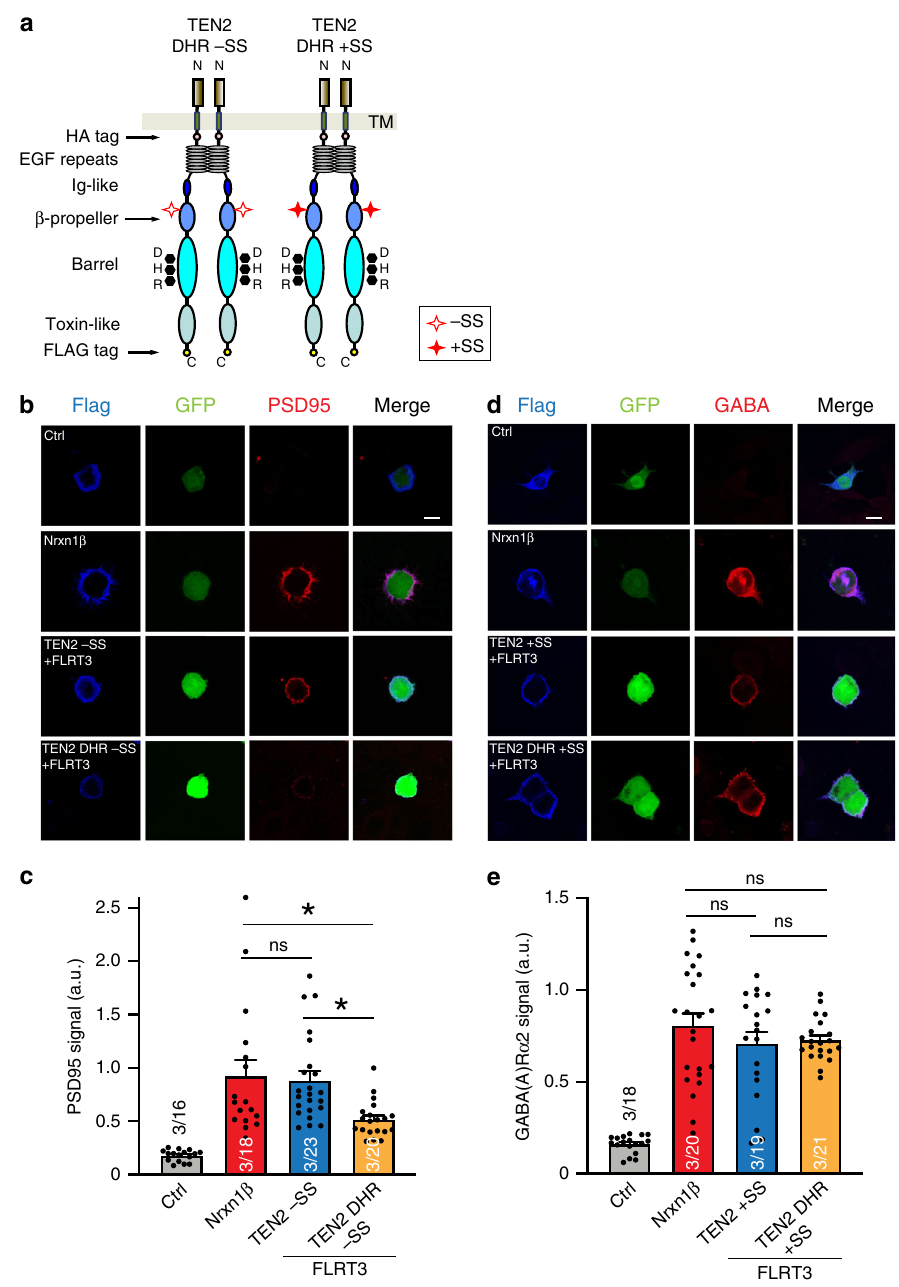
Fig. 7 Binding site mutations on TEN2 selectively abolish excitatory but not inhibitory synapse formation. a Diagram for TEN2 DHR − SS and TEN2 DHR + SS constructs that were used in the below experiments. The seven amino acid splice site on the TEN2 β -propeller is indicated by empty or fi lled red stars; DHR mutation is indicated by black dots. b , c Arti fi cial synapse formation assay showing that LPHN-binding mutant (DHR) of TEN2 − SS attenuated excitatory synapse formation. HEK293T cells are co-transfected with indicated cell-adhesion molecules and GFP, and co-cultured with cortical neurons. Cultures were subsequently immunostained for the excitatory postsynaptic synapse marker PSD95. Representative images ( b ) and quanti fi cations of PSD95 signals ( c ) are shown. d , e LPHN-binding mutant (DHR) of TEN2 + SS did not affect inhibitory synapse formation. Similar in b and c , except that immunostaining for the inhibitory postsynaptic synapse marker GABA(A) α 2 was performed. Scale bar in b and d indicates 10 µ m. Data in c and e are presented as mean ± SEM, n = 3, and are representative of at least three independent experiments. ns, P > 0.05; * P < 0.05 (one-way ANOVA). Source data are provided as a Source Data fi expression was performed by infection of High Five cells (Thermo Fisher, B85502) CATTCTGCCTTTGCGGCGGATCCCACTTCCTGTGCTGATAACAAGGAT in Insect-XPRESS medium (Lonza, 12-730Q) medium at a cell density of 2.0× 10 6 AATGAG-3 ′ and R: 5 ′ -GGATCAGATCTGCAGCTTAGTGATGGTGATGGTGA cells/ml for 72 h at 27 °C. TGCCTCTTTCCCATCTCATTCTGTC-3 ′ . The following primers were used for For the structural studies, TEN2 ECR Δ 1 (residues T727-R2648) and LPNH3 ECR (residues S21-V866) were cloned with carboxyl-terminal 6XHis-tags separately and co-expressed in High-Five insect cells. The following primers were used for ampli fi cation of High Five cells expressed human TEN2 ECR Δ 1: F: 5 ′ -